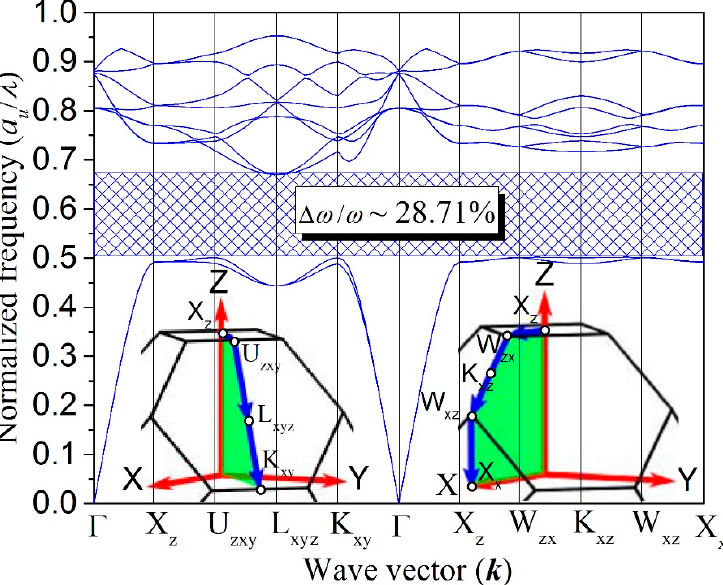
Figure 3. Bandgap diagram of the optimal inverse RCD (r = 0.27 au). The inset graphs show the movement described by the wave vector along the surface of the first Brillouin zone, in the corresponding left and right parts of the plot.